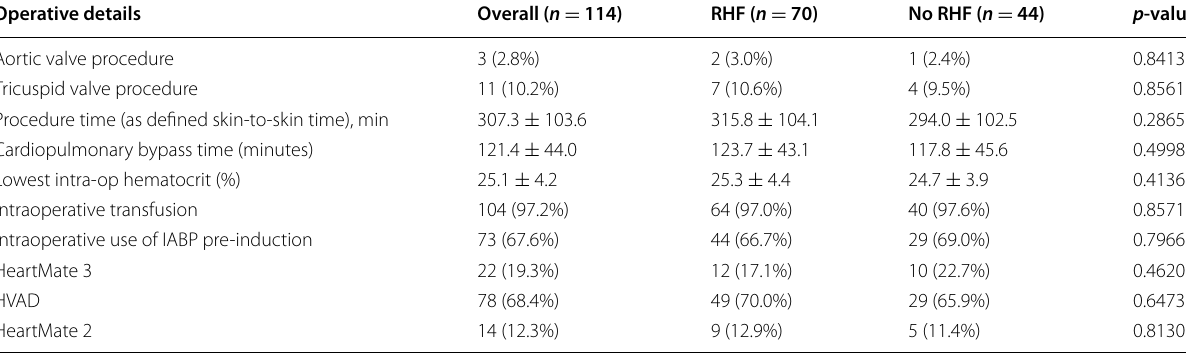
* p ‑values comparing patients with RHF vs. no RHF. **For continuous variables mean ventricular assist device. IABP intra‑aortic balloon